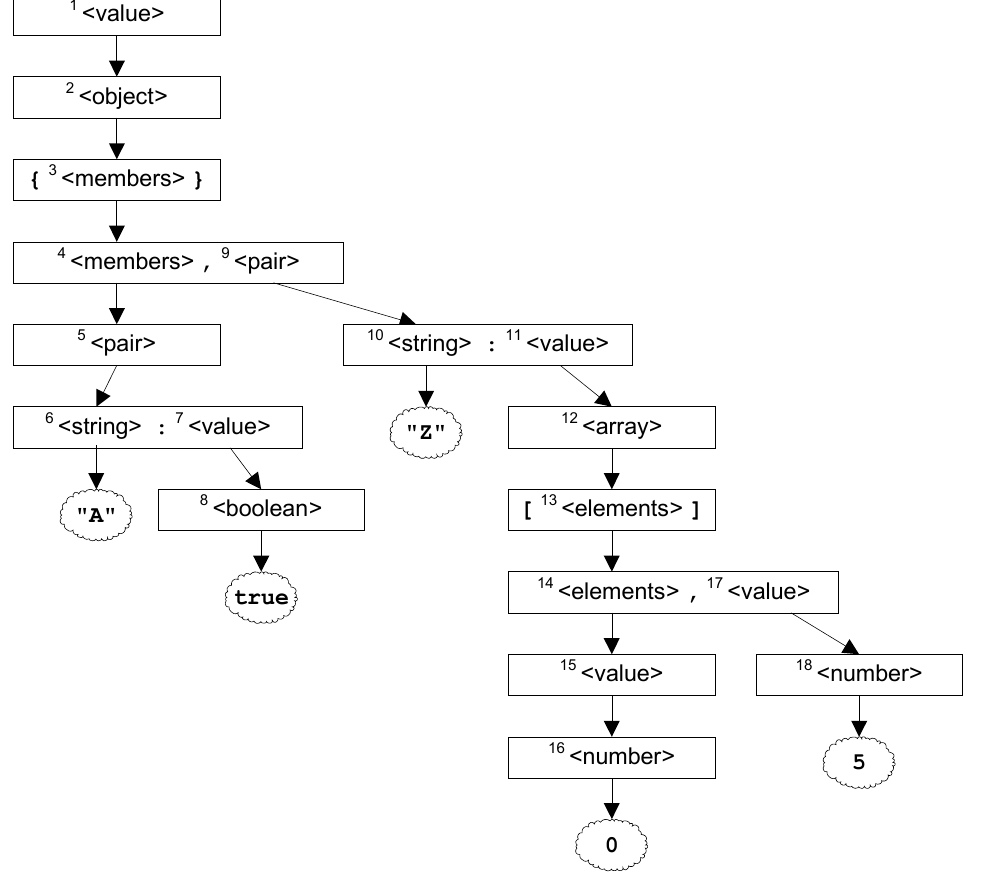
Figure 6. The syntax tree of the JSON object-type value {“A”:true, ”Z”:[0,5]}.